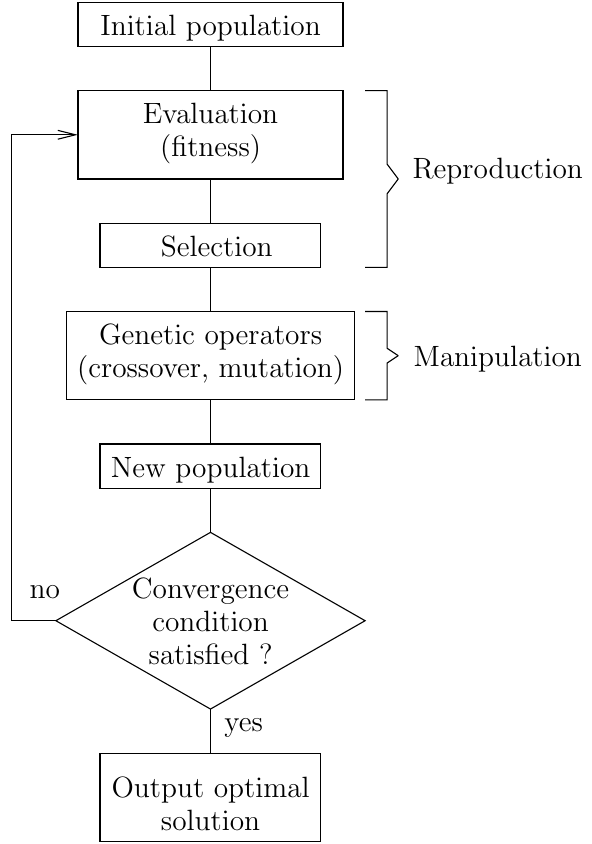
Fig. 2. Simple genetic algorithm (SGA)